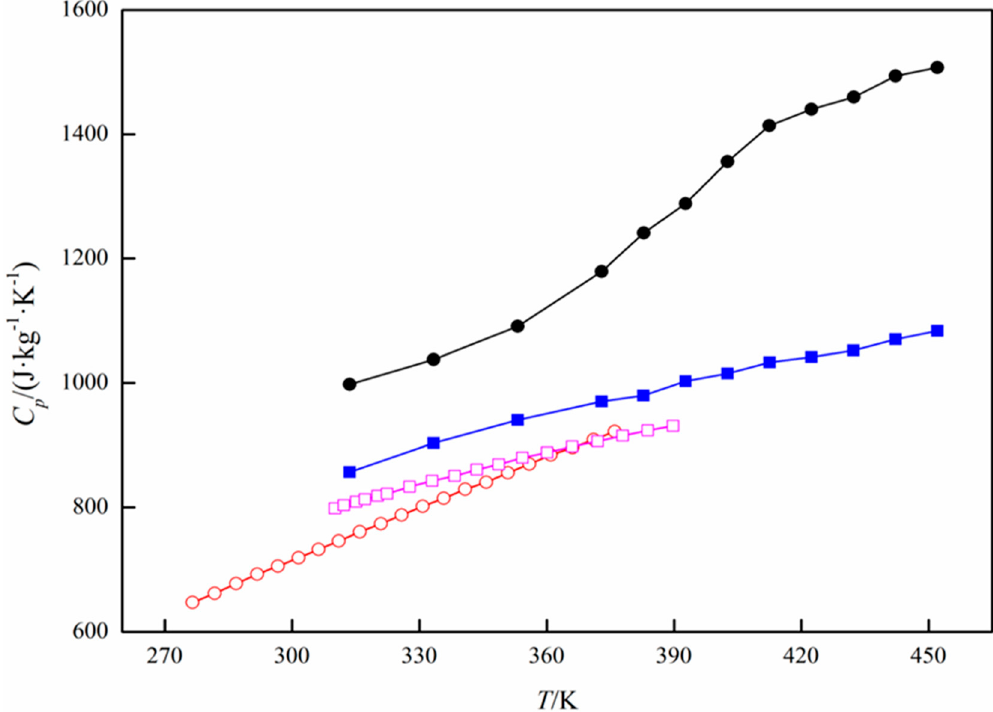
Figure 4. Comparison of C p values between the current work and references. • , activated carbon_exp; o, graphite_ref. [27]; ■ , Al 2 O 3 _exp; □ , Al 2 O 3 _ref. [27].